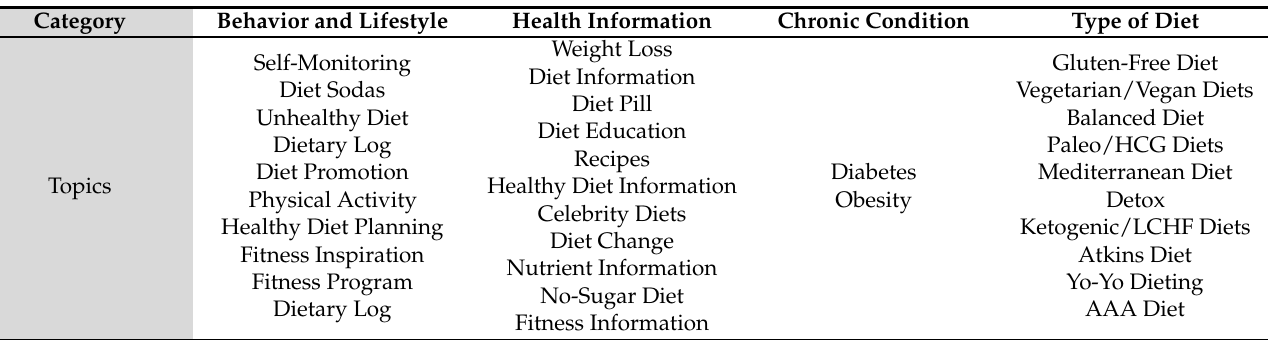
Table 5. Categories of topics.